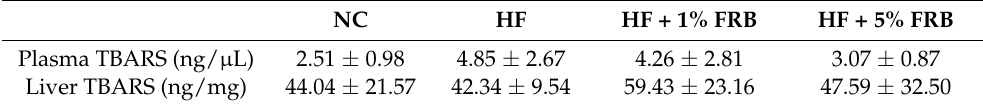
Table 4. Effects of the water extract of fermented rice bran (FRB) on plasma and liver thiobarbituric acid-reactive substances (TBARSs) in aged rats with high-fat (HF) diet feeding.